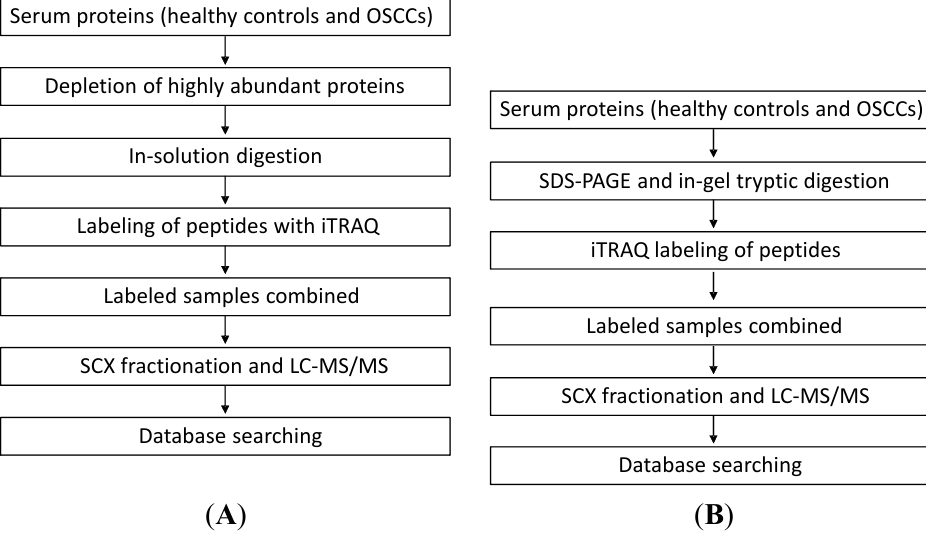
Figure 1. The workflow for the two proteomic approaches used to quantify serum proteins from patients with oral squamous cell carcinoma (OSCC). ( A ) In the first approach, we quantified serum proteins between OSCC and healthy control subjects by performing in-solution digestion of serum proteins, isobaric tags for relative and absolute quantification (iTRAQ) labeling of the resulting peptides, SCX (strong cation exchange) separation of labeled peptides and finally capillary LC with MS/MS analysis of the peptides; and ( B ) In the second approach, we first separated serum proteins with SDS-PAGE. The gel-separated proteins were then digested with trypsin and the resulting peptides were labeled with iTRAQ and analyzed with LC-MS/MS for protein